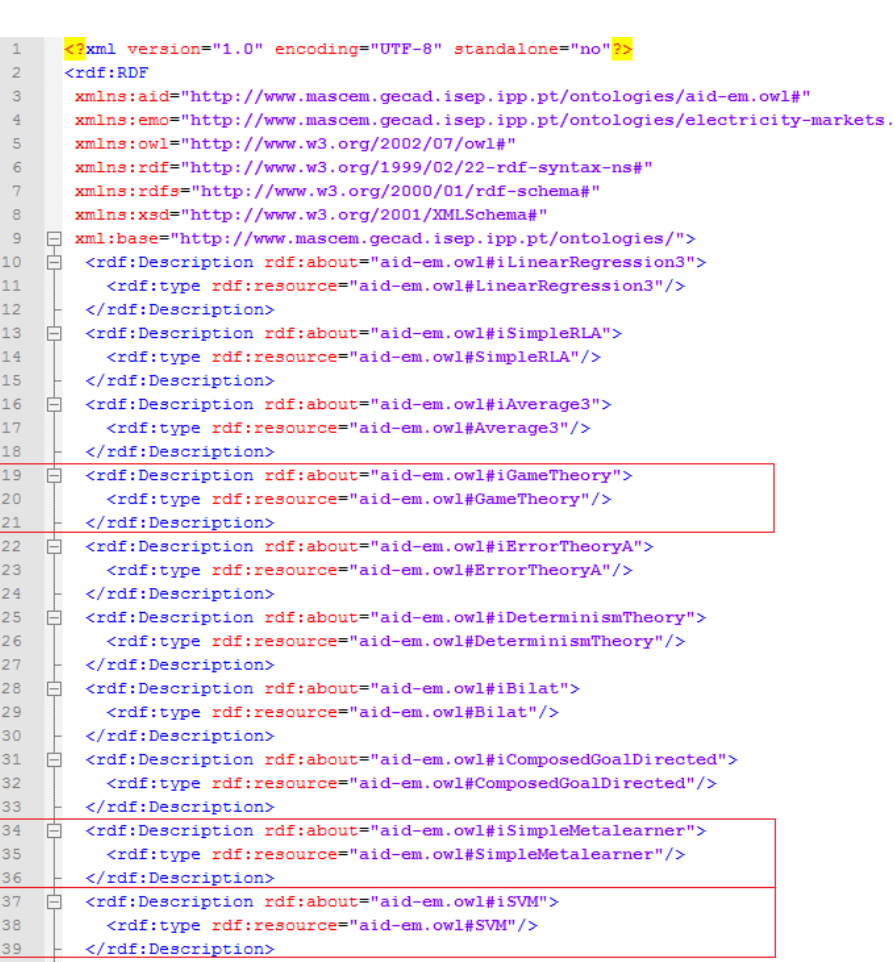
Figure 7. AiD-EM manager agent response to Player 56’s request for